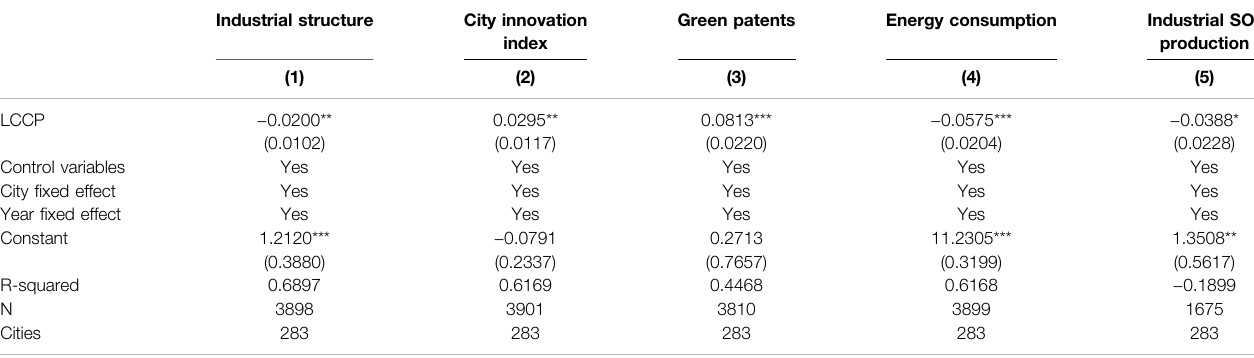
TABLE 4 | LCCP and industrial structure, technological innovation, and energy consumption. Industrial